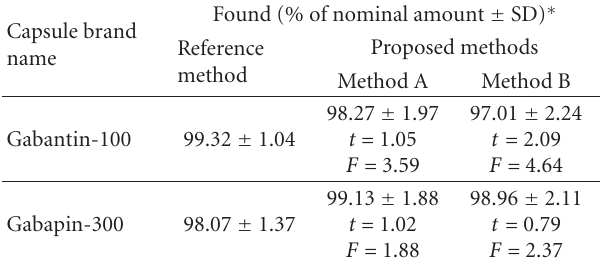
Tabulated F -value at the 95% confidence level is